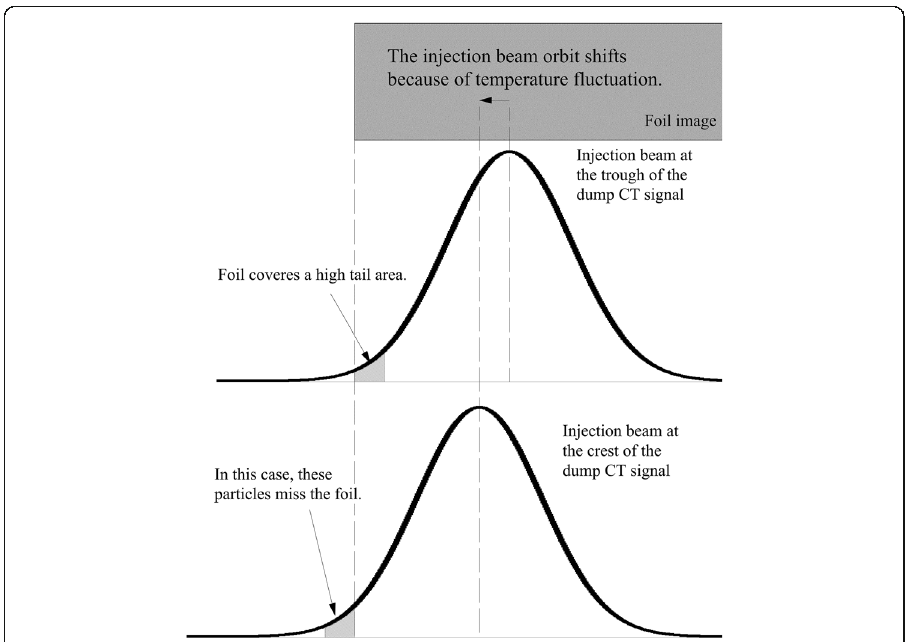
Fig. 4 Relation between injection beam profile and foil